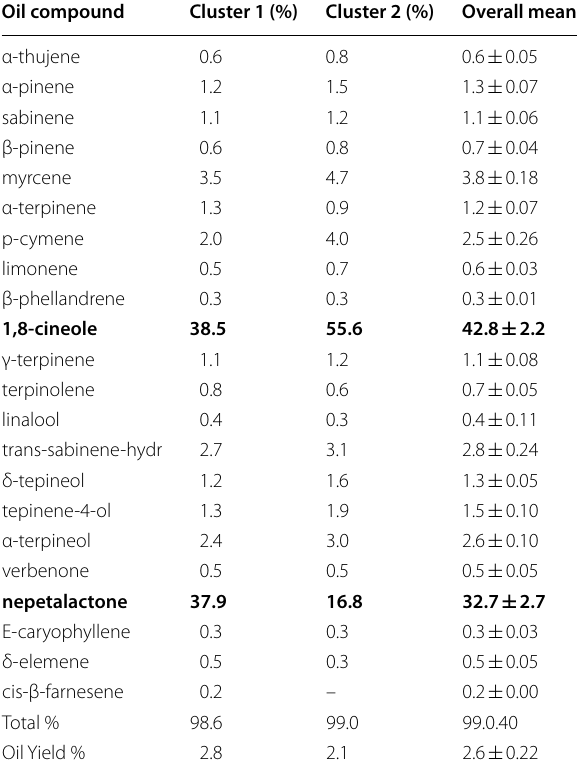
Table 4 Means of essential oil compound of Nepeta binaludensis in clusters 1 and 2 and mean of 20 localities in Binalud Mountain, Mashad, Iran